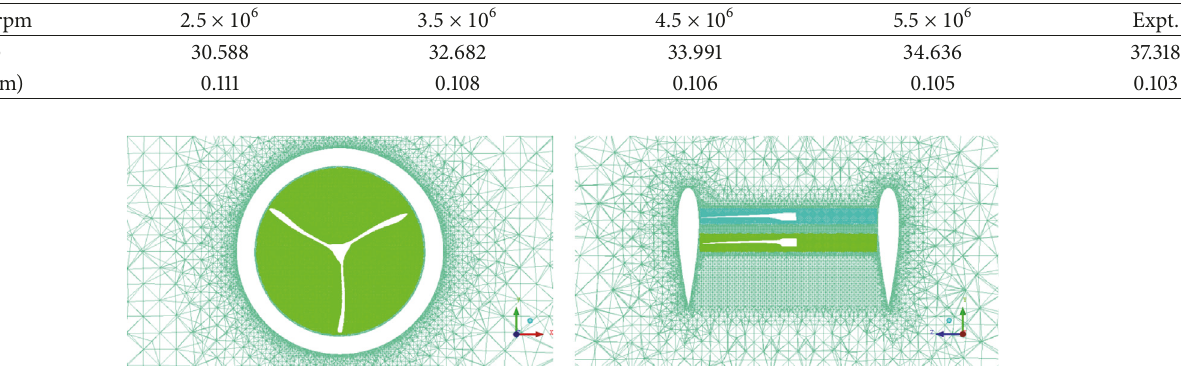
Figure 6: Space grids slices of nested grid system (grid quantity: 5.5 × 10 6 ).